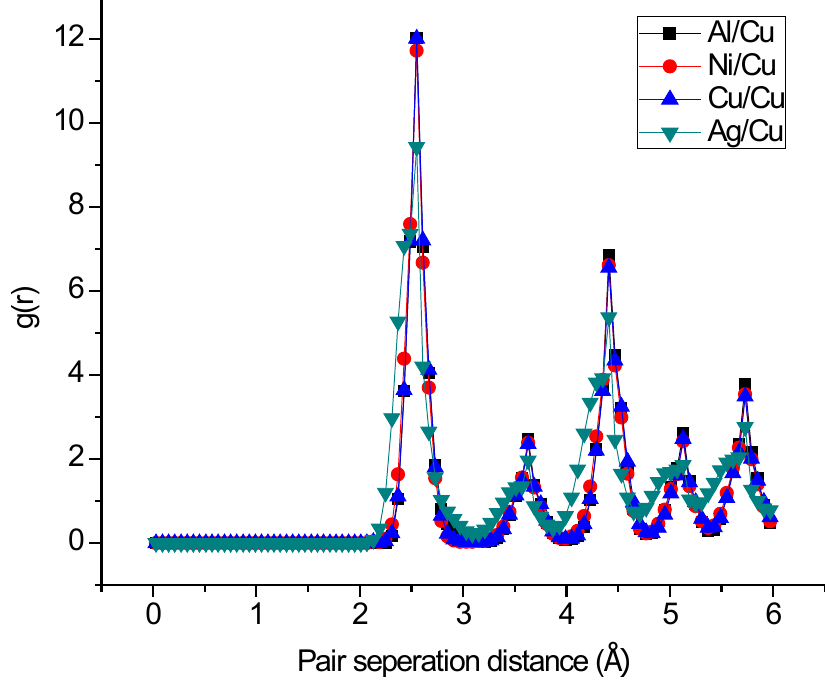
Figure 7. Radial distribution function with a different material combination of Al/Cu, Ni/Cu, Cu/Cu, and Ag/Cu after the cold gas dynamic spray at 20